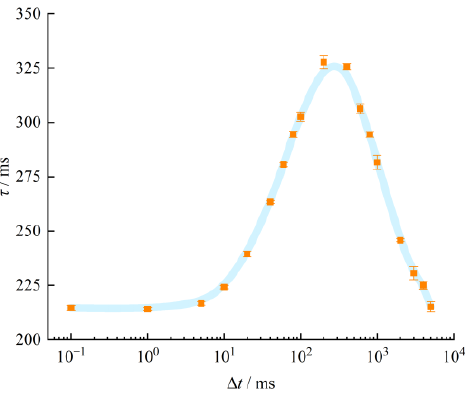
Figure 6. The comparison of output response curves under single and double pulse laser: ( a ) Com- parison of falling edges of output response curves; ( b ) Comparison of the falling edge of the output response curve after amplitude normalization.